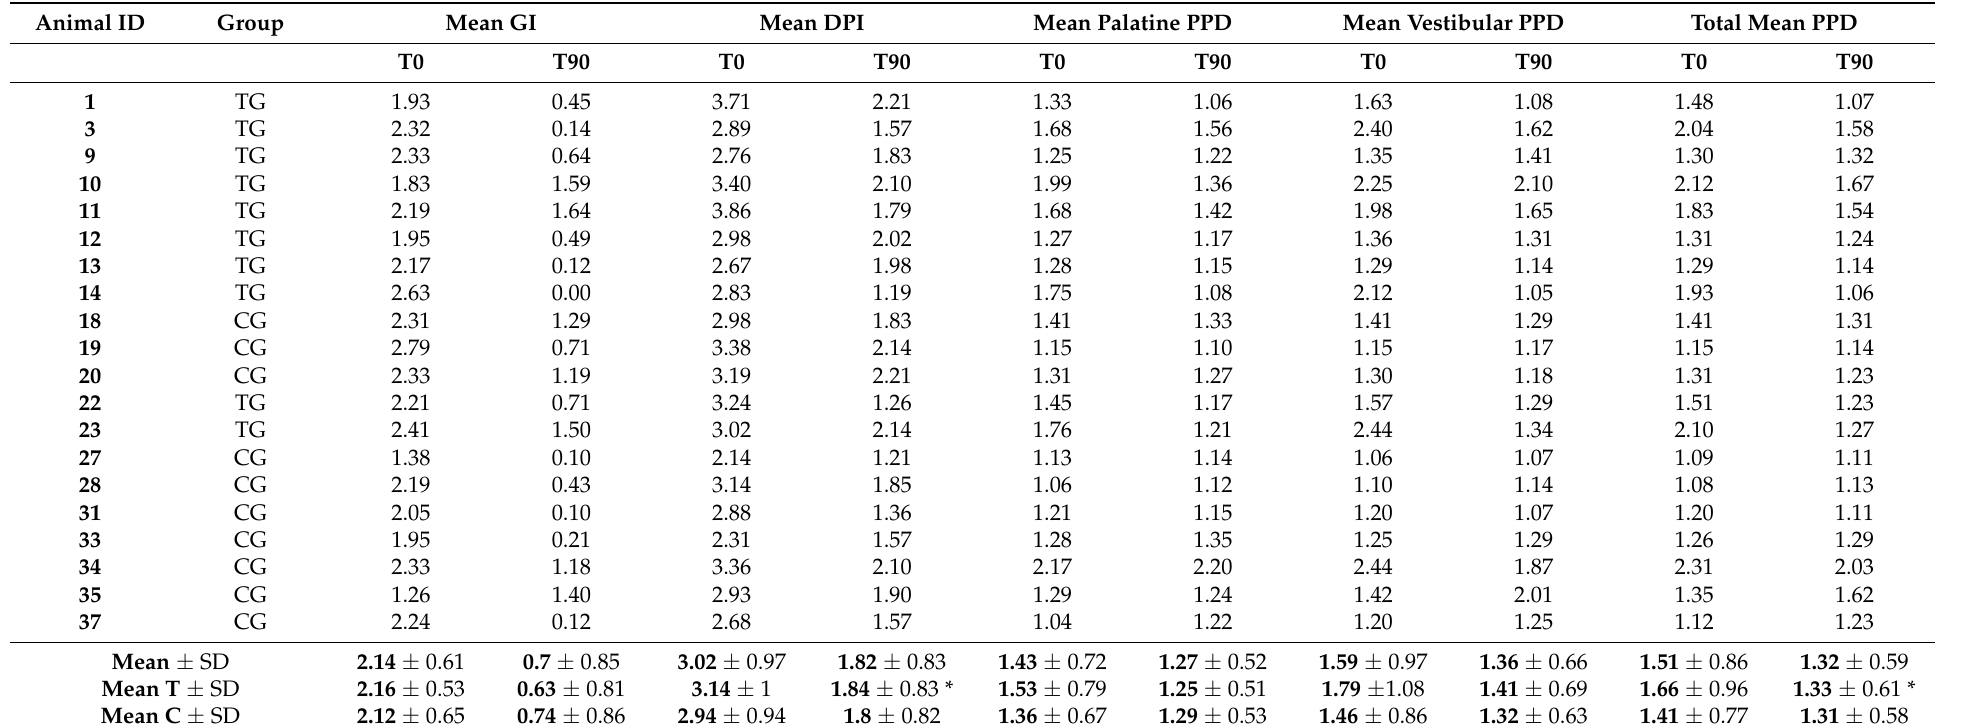
Table 5. Mean gingivitis, dental plaque, and periodontal pocket depth of each dog by timepoint. Animal